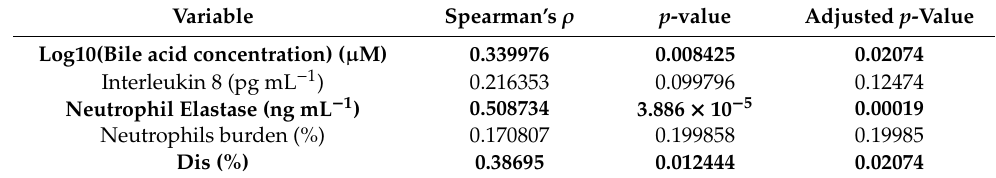
Table 1. The table represents the correlation between CSS-transformed pathogen counts, and the detection of the indicated cytology and inflammatory markers and bile acid levels in BALF. We used Spearman’s ρ to test for associations between variables. Uncertainty level is reported as p -values calculated using Spearman’s test. To control the false discovery rate (FDR), p -values were adjusted by applying Benjamini & Hochberg correction method (adjusted p -value). Significant associations are highlighted in bold. Dis (%) represents the percentage of structural lung disease quantified using the PRAGMA scoring method